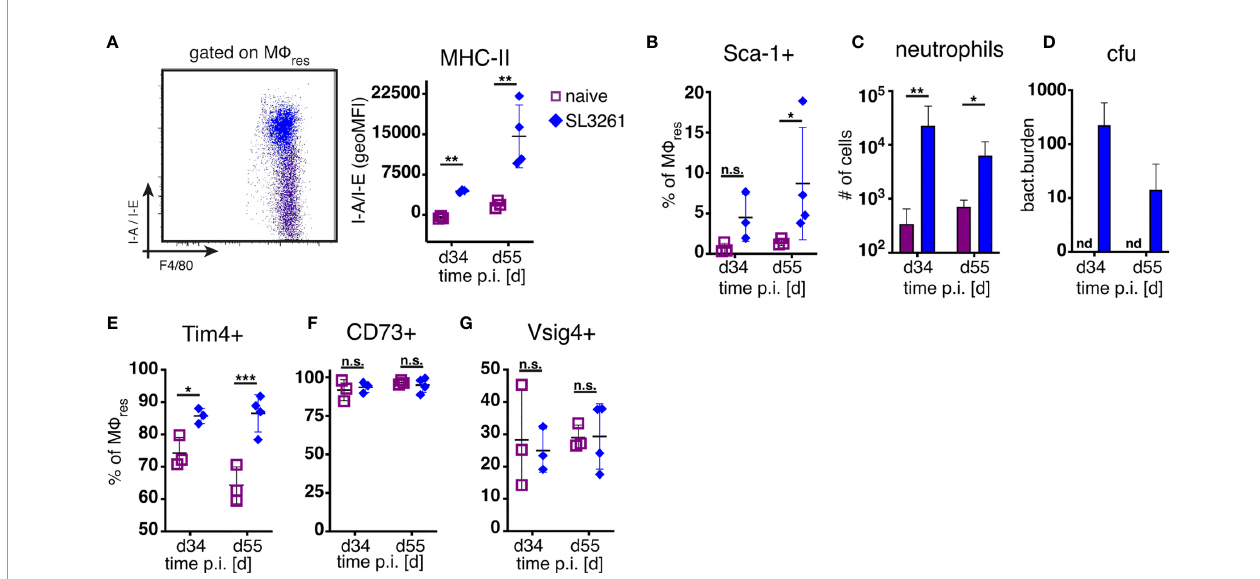
FIGURE 3 | Chronic in fl ammation induced by S.Typhimurium infection does not phenocopy repeated PD fl uid injection. C57BL/6 mice were infected orally with 1x10^8 cfu S.Typhimurium (closed rhombus) or left untreated (open squares) and peritoneal cells analysed 34 (d34) and 55 days (d55) post infection. Dotplot (d55) and quanti fi cation of MHC-II (A) and Sca-1 (B) expression by M F res assessed by fl ow cytometry (C) Number of peritoneal neutrophils. (D) Enumeration of bacterial colony forming units present in the peritoneal cavity. (E – G) Expression of M F res associated cell surface markers assessed by fl ow cytometry. Datapoints depict individual animals and bars/lines indicate mean with SD. Data representative of one (d34) or two (d55) separate experiments using 3-4 animals per group per timepoint. Data analysed using 2-way ANOVA followed by Tukey ’ s post-hoc test after transformation. n.s., not signi fi cant; *p < 0.05; **p < 0.01; ***p < 0.001.